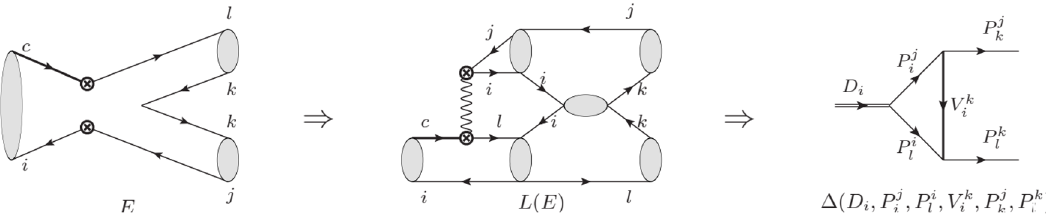
Figure 3 . Topological diagram ⇒ Topological-scattering diagram ⇒ Triangle diagram in T ⇒ E transition. The first right arrow represents the t -channel long-distance contributions induced by the short-distance T amplitude in the E diagram can be described by the topological-scattering diagram L ( E ) . The second right arrow represents the topological-scattering diagram L ( E ) in quark level is equivalent to the triangle diagram ∆( D i , P j